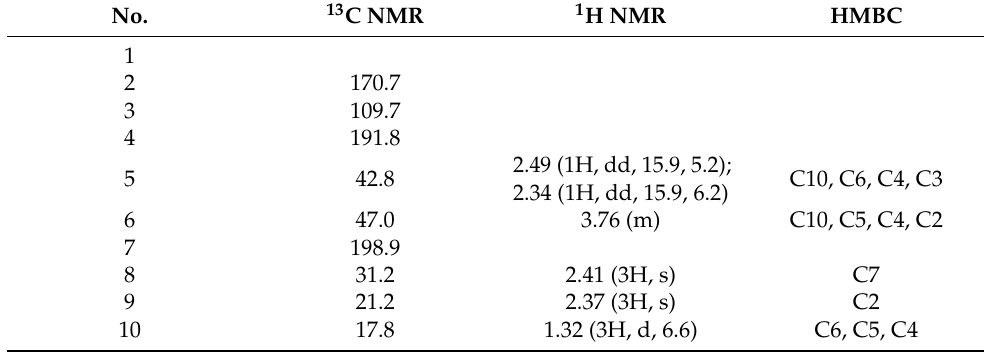
Table 2. NMR data of compound 2 (500 MHz for 1 H NMR, 125 MHz for 13 C NMR, CD 3 OD).